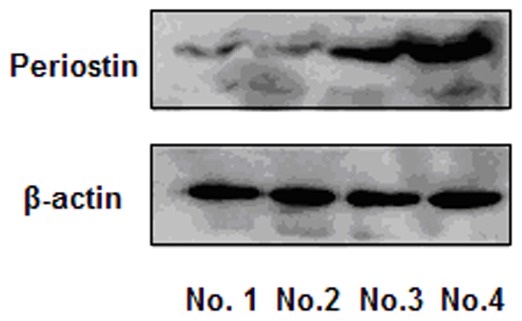
Western blots show that periostin protein was expressed high in CSC cells.Periostin protein was expressed higher in CSC cells (No. 4) compared to the CD44- tumor cells (No. 1), CD44+/CD24+ tumor cells (No. 2), and unsorted cells (No. 3).